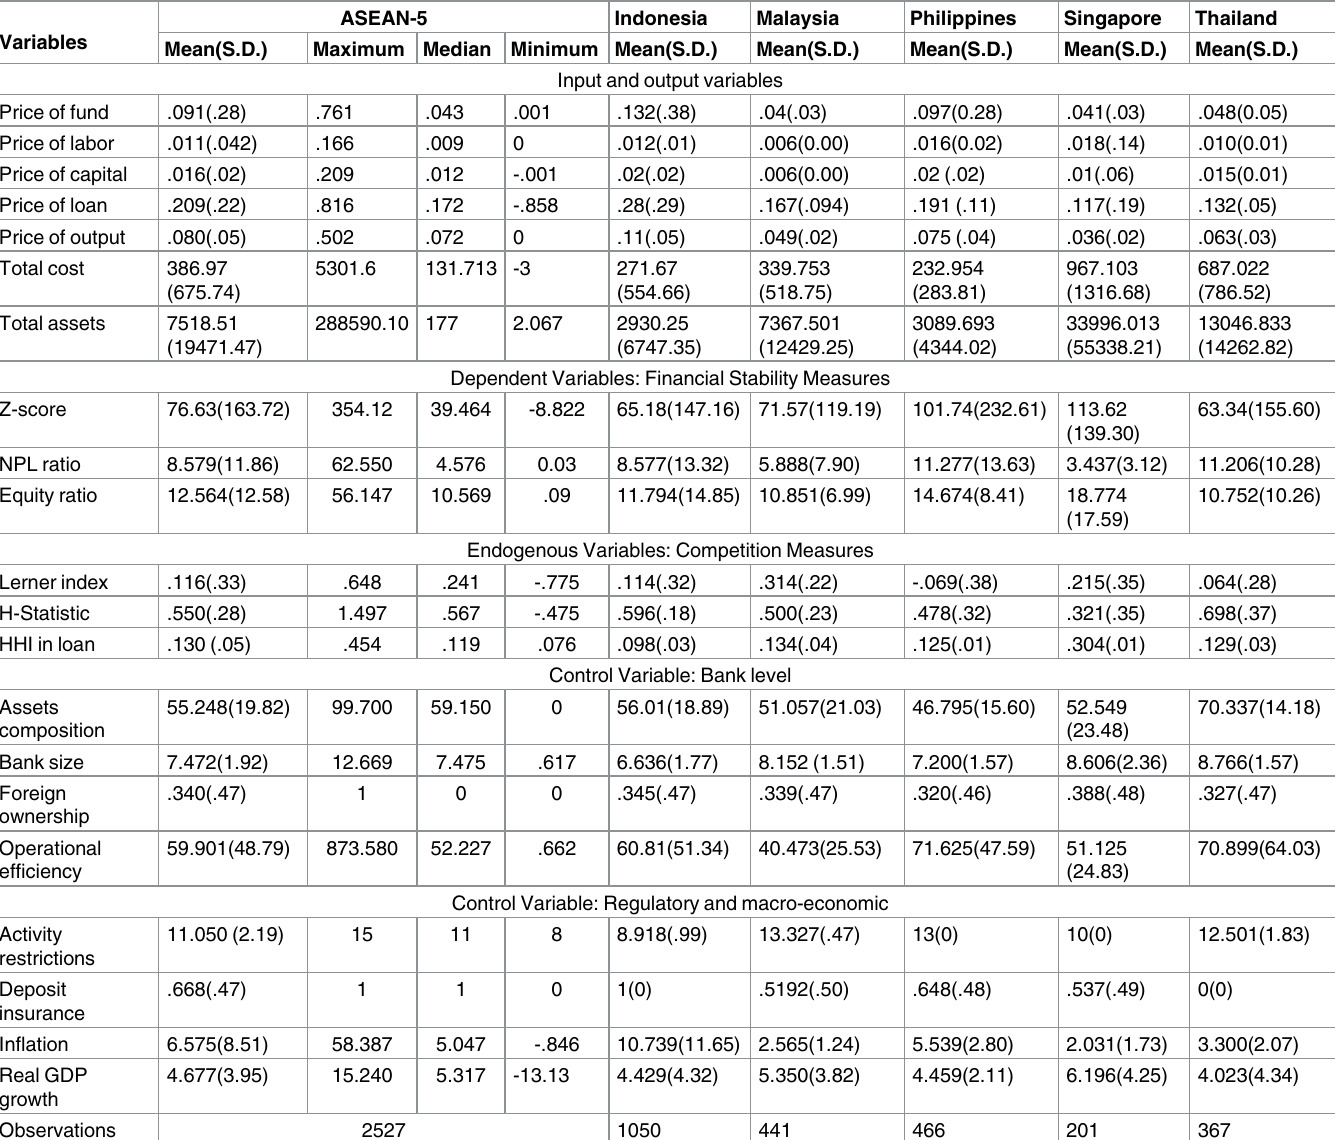
Table 1. ASEAN-5 and country wise descriptive statistic of the